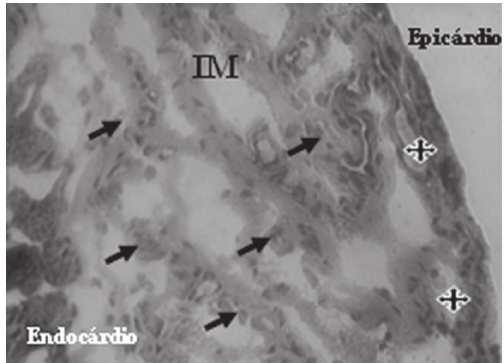
Fig. 4 - Células endoteliais (flechas) e neovasos (estrelas) identificadas após o transplante de células mononucleares no infarto do miocárdio (IM) - Tricrômio de Gomery,